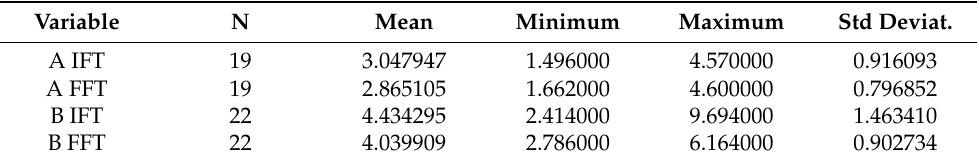
Table 5. Basic characteristics (number of observations N, mean, standard deviation SD, min, max) for the delta variable = max (accelerations) − min (accelerations).